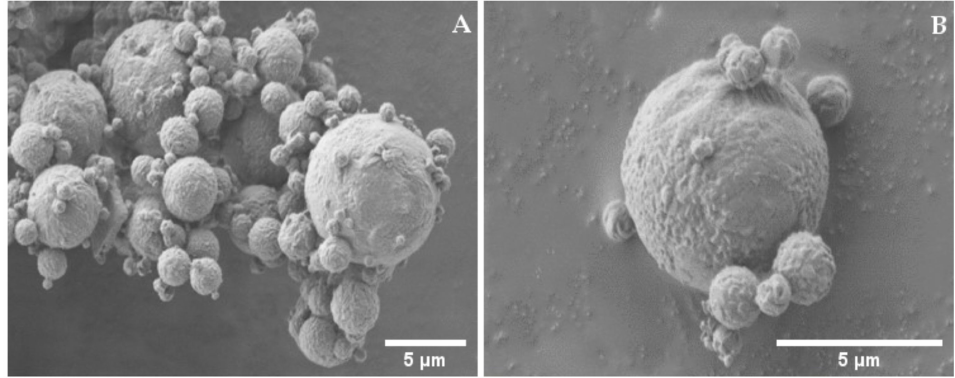
Figure 4. SEM picture of DEX microparticles taken at ( A ) 1000 × and ( B ) 20,000 × magnifications.